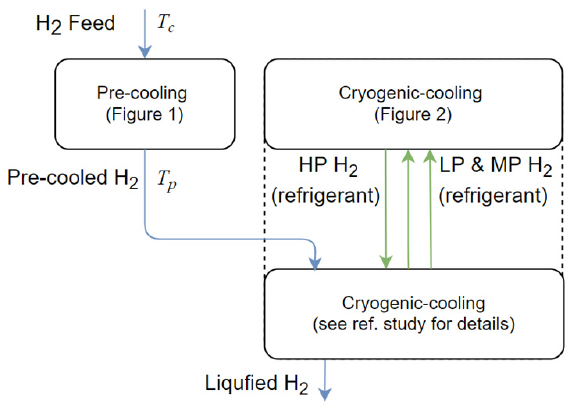
Figure A1. Block flow diagram of the overall liquefaction process.